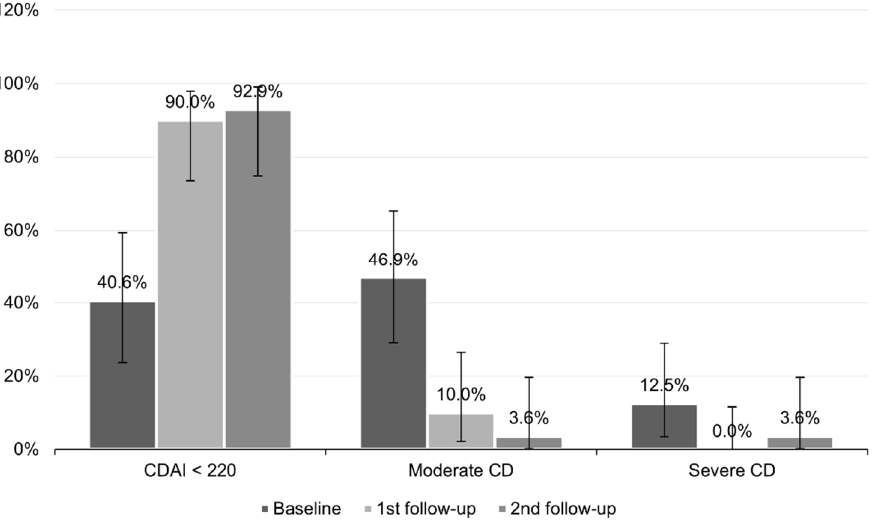
Figure 4. Severity of CD in patients at baseline, 1st follow-up, and 2nd follow-up. Horizontal lines represent 95% confidence intervals (CI).